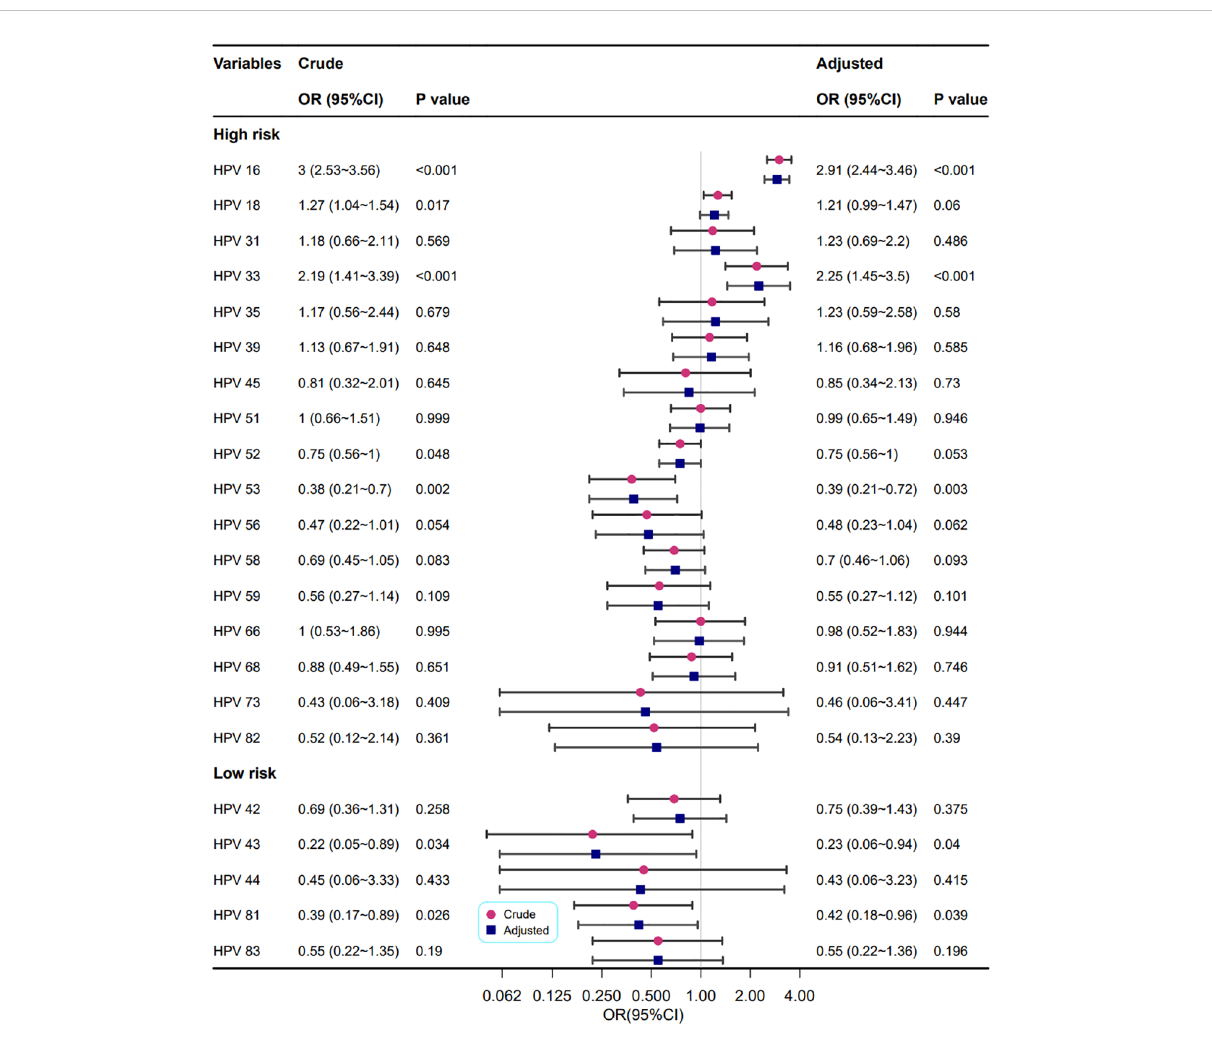
FIGURE 7 Association between multiple HPV infection and cervical vascular abnormality. Model adjustments for age, gravidity, and parity.